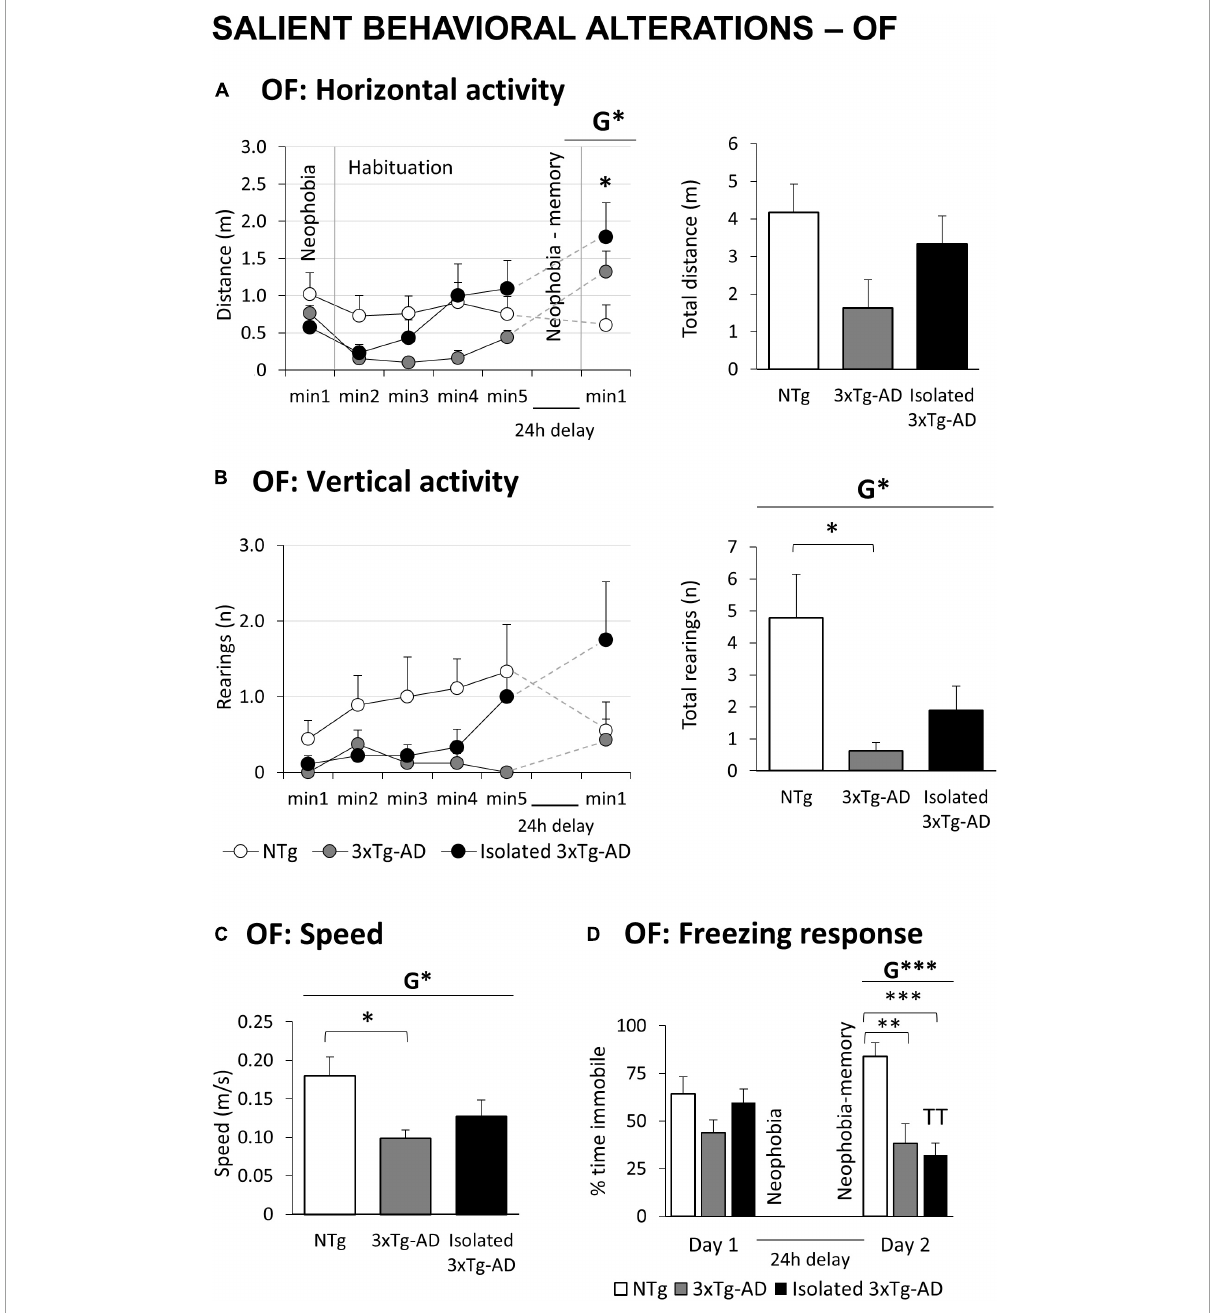
FIGURE1 Salient behavioral alterations in 18-month-old female 3xTg-AD mice in the open field tests compared to NTg females with normal aging. Results are expressed as mean ± SEM. (A) OF: Open field test Horizontal activity: left, time course; and right, total distance; (B) vertical activity: left, time course; and right, total number; (C) speed; (D) freezing response. Statistics: Students t -test: G, genotype effect, G* p < 0.05, G** p < 0.01, G*** p < 0.001. ANOVA for comparisons between all the groups of mice followed by Bonferroni’s post-hoc test: * p < 0.05 and *** p < 0.01 vs. the NTg-group. Paired t -test, TT p < 0.01 vs. the same group on Day 1.